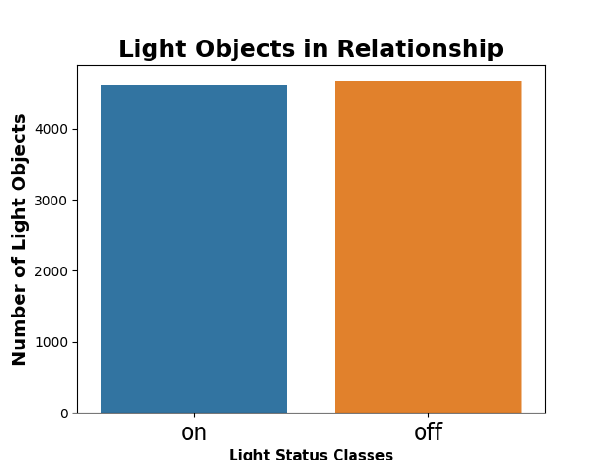
Figure 15. Traffic objects in relationship.